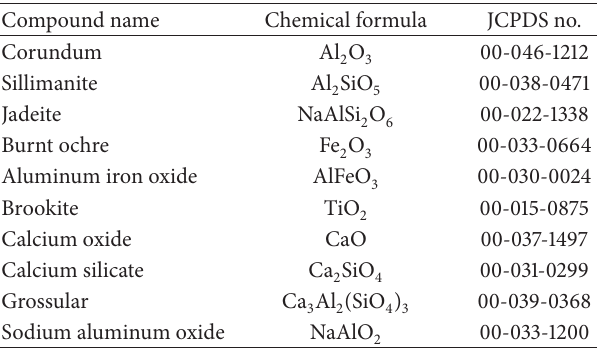
Table 5: Mineralogical phases in sintered red